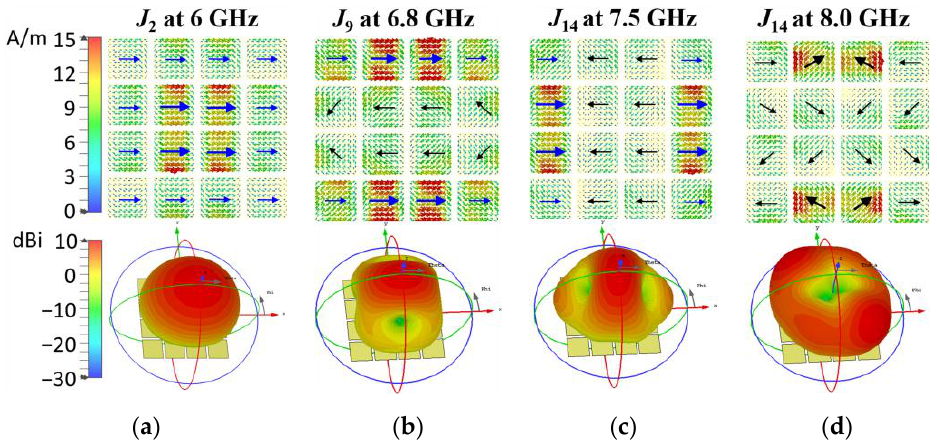
Figure 3. Modal currents J n ( ω ) and radiation patterns of MTS1 at the resonant frequencies and the frequency end. ( a ) Mode 2 at 6 GHz, ( b ) Mode 9 at 6.8 GHz, ( c ) Mode 14 at 7.5 GHz, and ( d ) Mode 14 at 8.0 GHz.